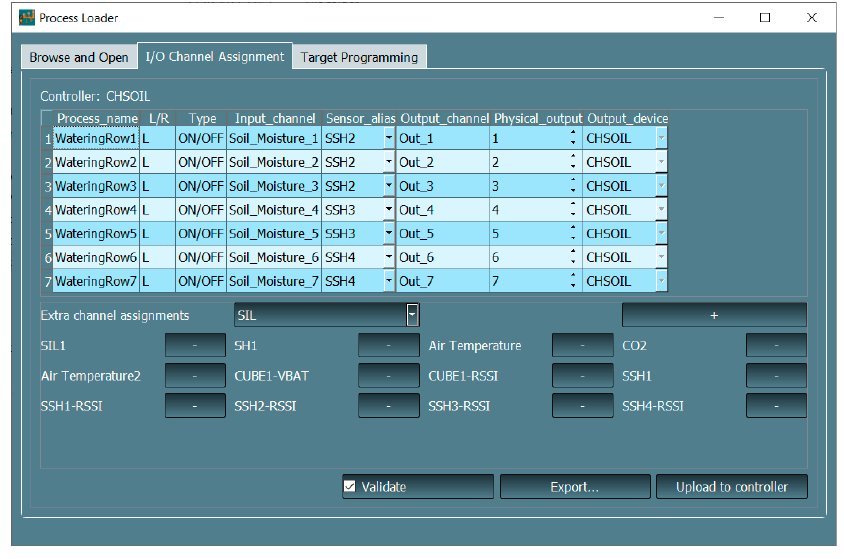
Figure 23. Process Loader interface.